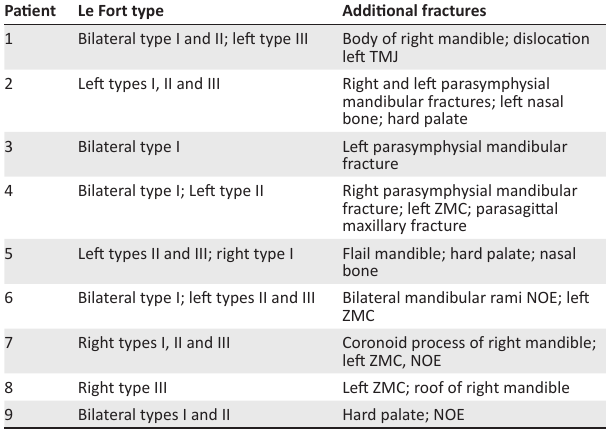
TABLE 2: Cases with Le Fort plus additional fractures.